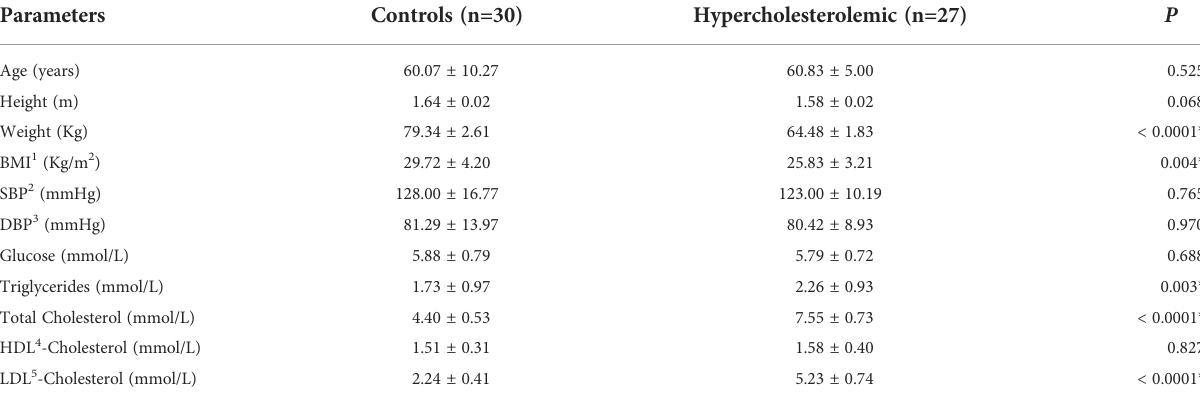
TABLE 1 Anthropometric and biochemical characteristics of hypercholesterolemic individuals and controls.